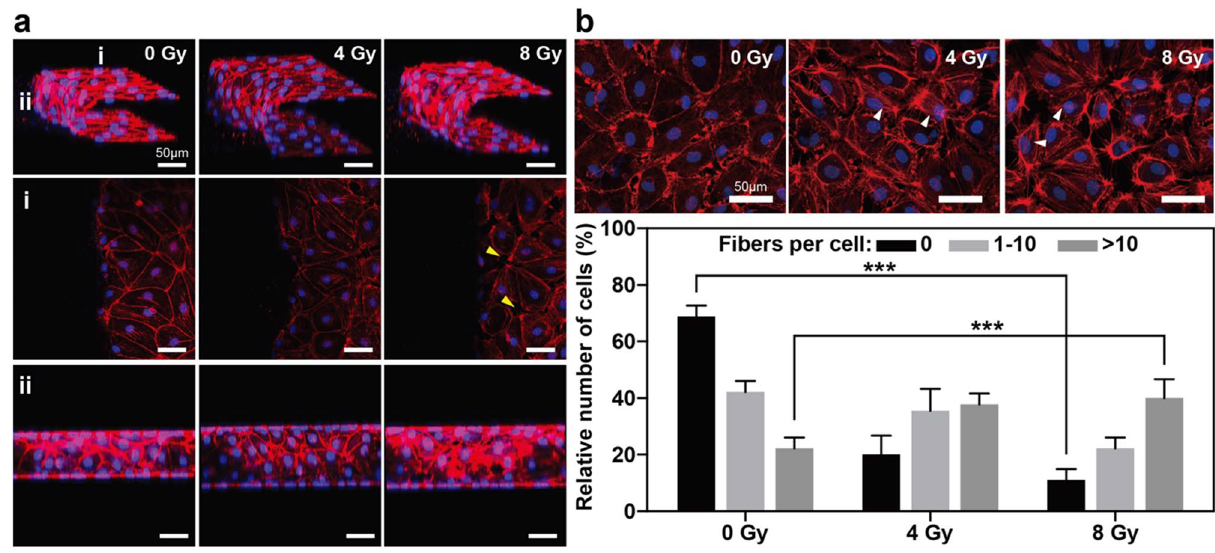
Figure 2. Immunofluorescence images of F-actin and quantification of actin stress fibers in hMVECs after gamma irradiation. ( a ) The structure and alignment of the actin filaments in the hMVECs changed after the gamma irradiation exposure. ( b ) Representative immunofluorescence images of F-actin and quantification for the percentage of cells with different numbers of actin stress fibers after gamma irradiation. (scale bar: 50 µm, * p < 0.05; ** p < 0.01; *** p < 0.001, n = 3 (15 randomly chosen hMVECs = 1)). Statistical comparison were calculated with two-tailed t-tests using Prism (7.0a, GraphPad software, www. graph pad. com). Images were analyzed using ImageJ (1.52q, NIH, www. imagej. nih. gov/ ij). All the images and graph were created with Adobe illustrator (CC 2019 23.0.1, www. adobe. Gamma irradiation induced loss of cell‑to‑cell junction and increased endothelial barrier per‑ meability. In general, it is natural for endothelial cells to form a tight monolayer with the neighboring cells. There are several tight and adhesion junctions in endothelial cells, which include VE-cadherin, Claudin 5, Zo-1, and occludin. These tight junctions (TJs) and adhesion junctions (AJs) mediate the endothelial cell contacts, but they also provide different functions in the endothelial barrier. VE-cadherin, which is a unique AJ in endothelial